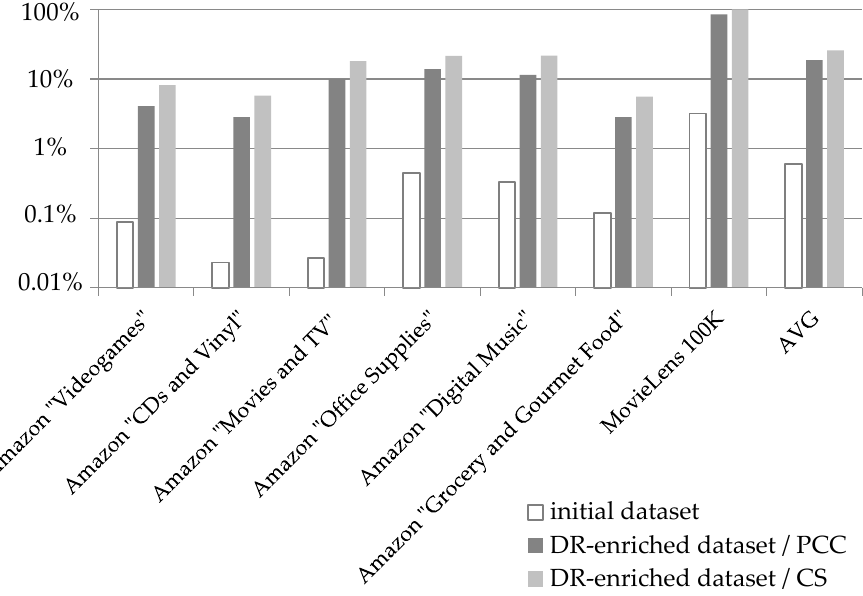
Figure 5. Dataset density before and after the insertion of DR in the rating database.